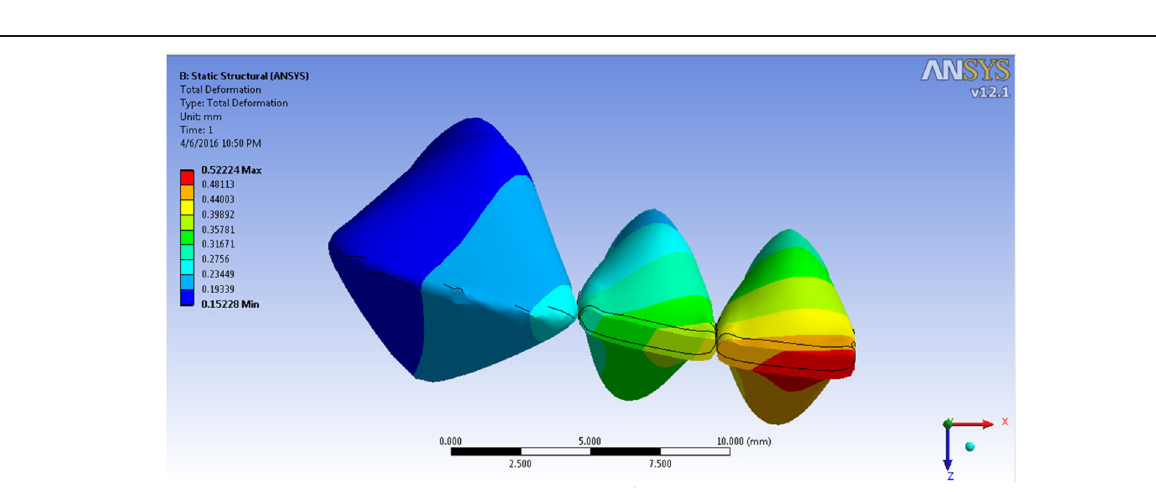
Fig. 7 Total deformation in the teeth of the third model (the inclination of the anterior teeth at 100° to the horizontal